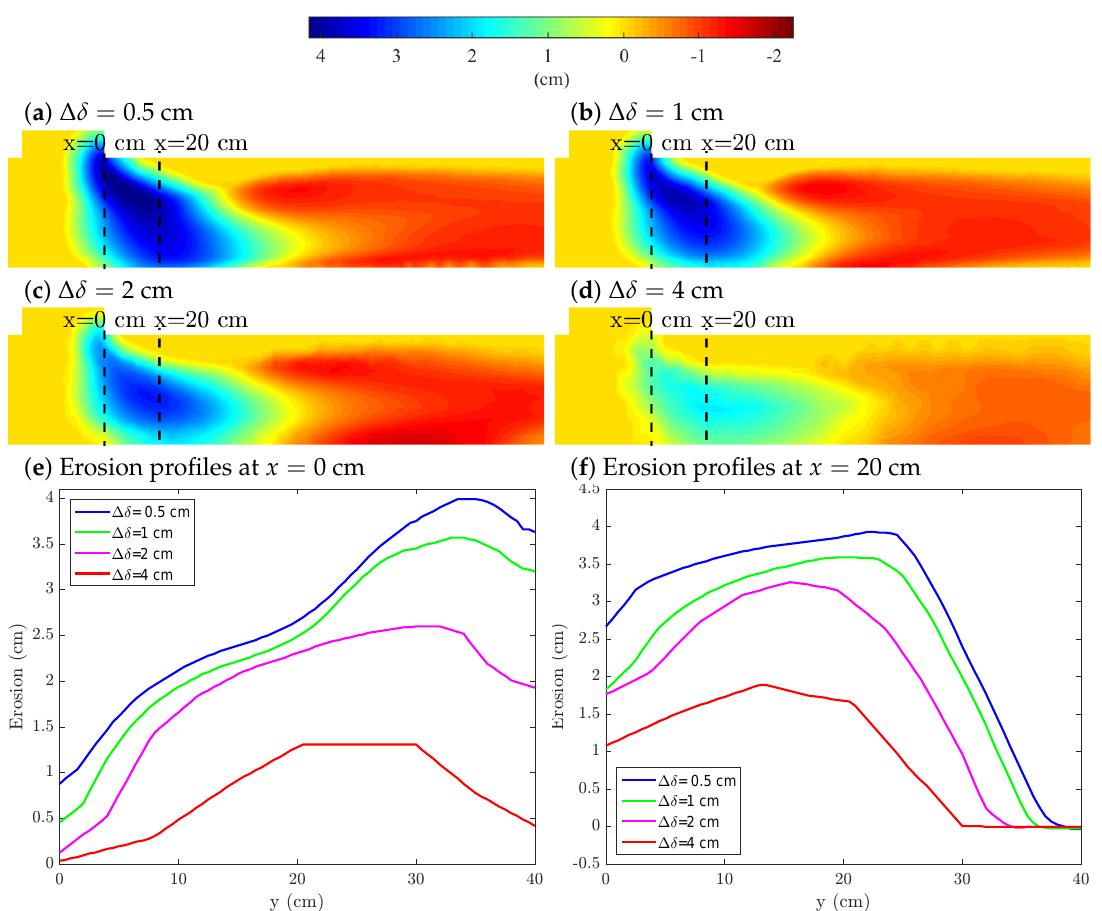
Figure 5. Mesh refinement study. We plot the erosion patterns for four increasingly refined meshes: in panel ( a ) the mesh size, ∆ δ , is 0.5 cm, in panel ( b ) 1 cm, in panel ( c ) 2 cm, and in panel ( d ) 4 cm. We plot two erosion profiles of the main channel at x -coordinate 0 cm in panel ( e ) and x = 20 cm in panel ( f ). The reference system is depicted in Figure 3a. Erosion is positive and sedimentation